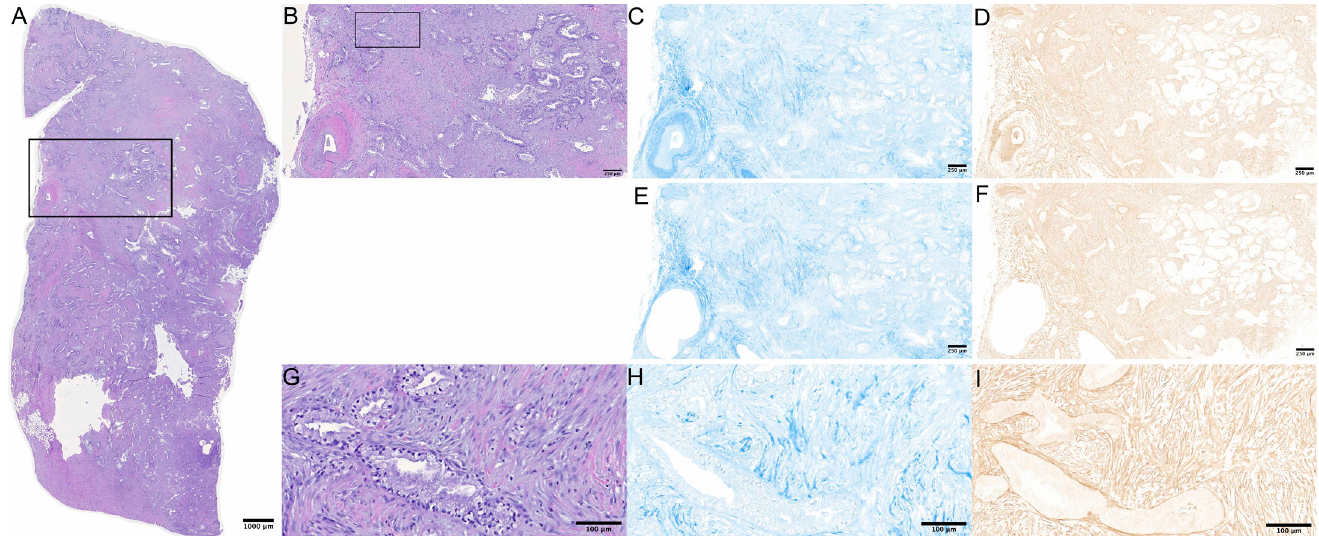
Figure 1. Representative example of histological slides: ( A ) whole slide overview, H&E staining; bar represents 1000 µm. ( B ) Zoom of marked cutout of panel a; bar represents 250 µm. ( C ) Consecutive section corresponding to ( B ), aniline blue staining; ( D ) consecutive section corresponding to ( B ), α -SMA immunohistochemistry; ( E , F ) represents ( C , D ) after manual exclusion of vessels, respectively; ( G ) zoomed cutout of ( B ); bar represents 100 µm; ( H ) consecutive section corresponding to ( G ), aniline blue staining; ( I ) consecutive section corresponding to ( G ), α -SMA immunohistochemistry.